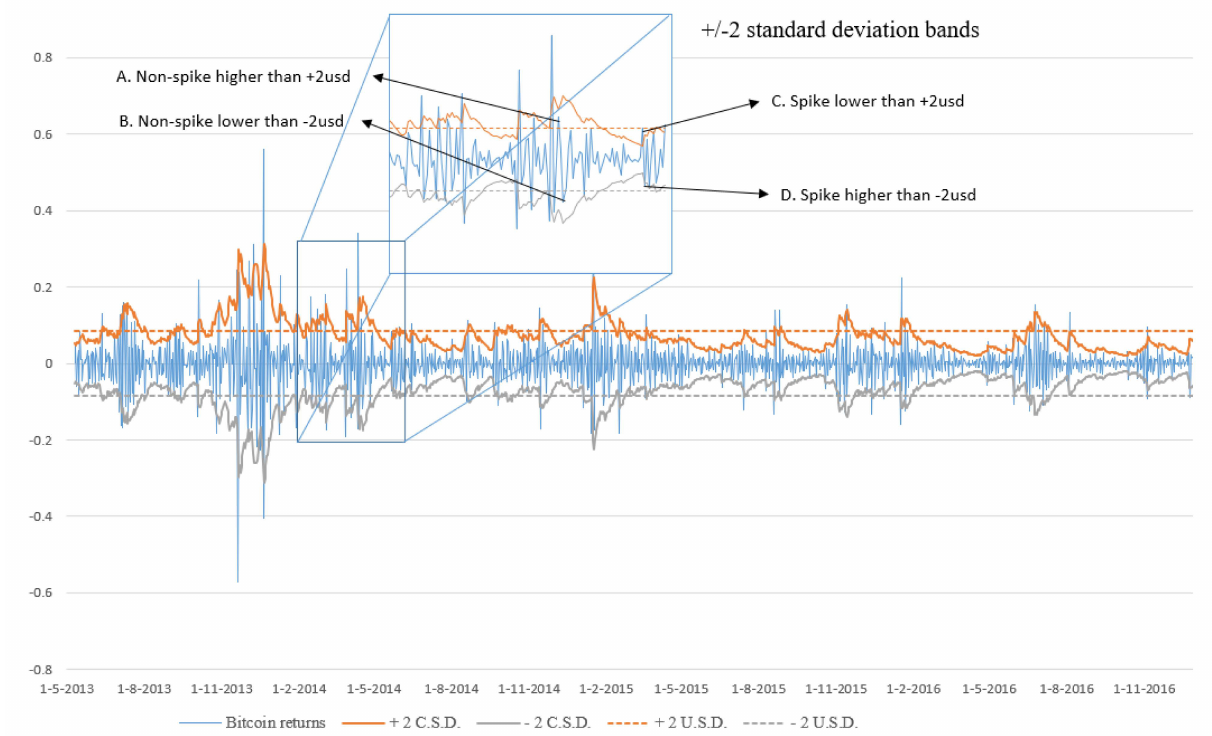
Figure 3. The two conditional standard deviation bands (2-csd) and the two unconditional standard deviation bands (2-usd) are graphically represented above. The 2-csd band is depicted with the squiggly line and the 2-ucd is depicted by the dashed parallel lines. The data points (returns) outside the 2-csd band are noted as spikes. We present four separate situations in the zoomed-in portion that differ between the conditional and unconditional standard deviation